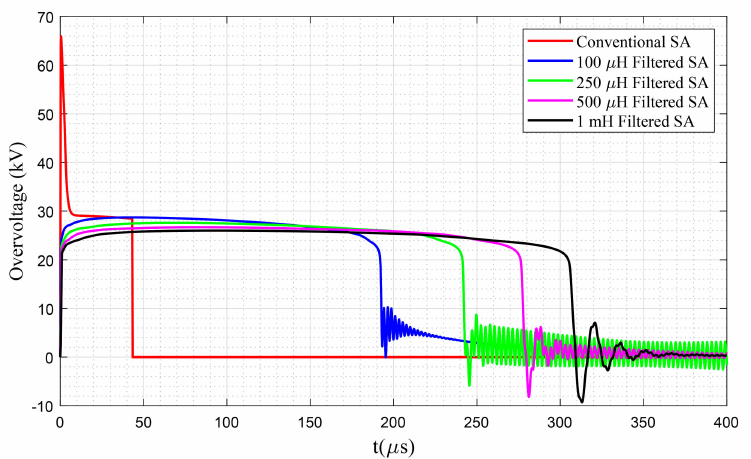
Figure 25. Comparison of the overvoltage stress of MV transformer protected by conventional surge arrester SA-12b (no filter) and filtered surge arrester with di ff erent filter sizes under the 125 kV lightning